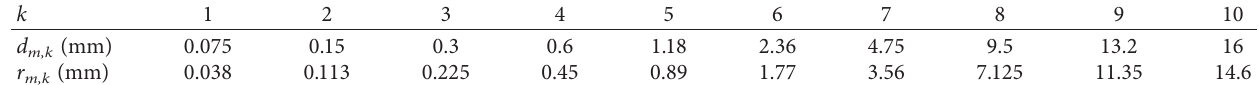
Table 1: Commonly used standard sieve sizes and corresponding particle sizes of mineral aggregate.